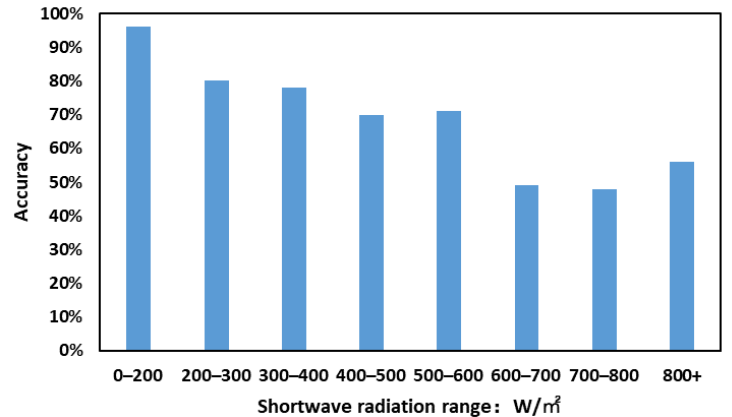
Figure 6. Data accuracy under different shortwave radiation bands.